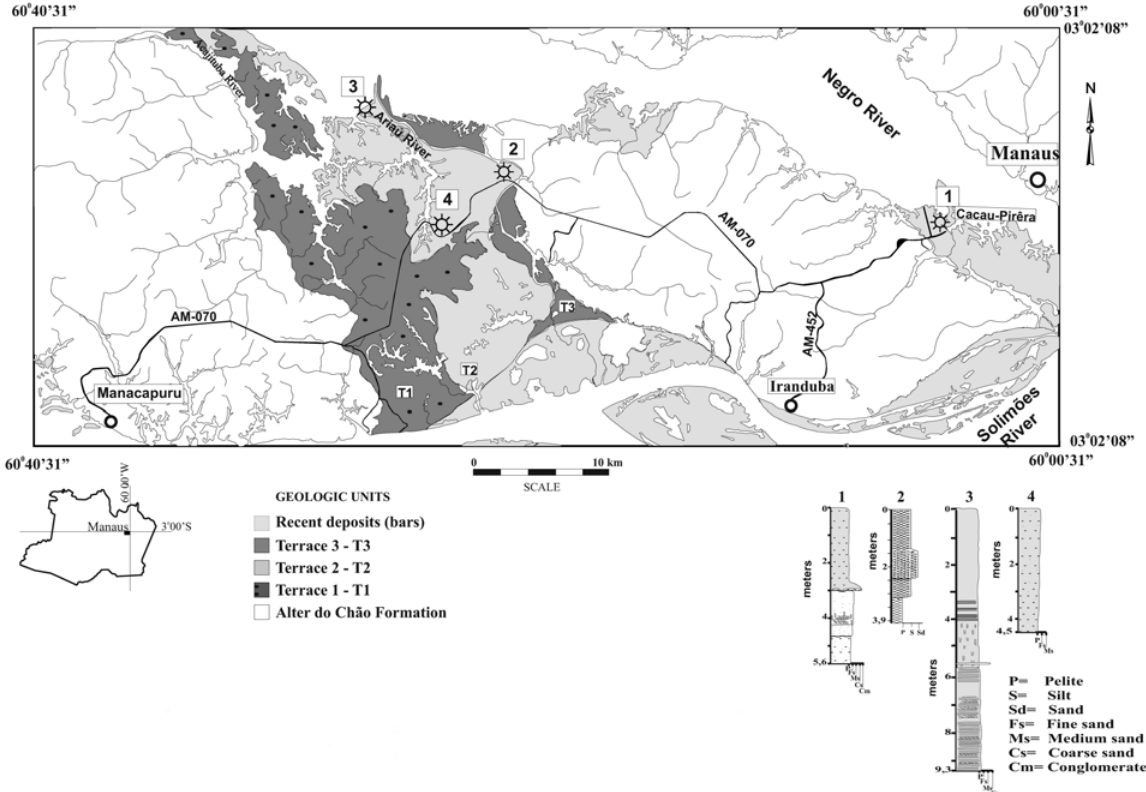
Fig. 5 – Geological map with the location of the Iranduba and Ariaú region with stratigraphic sections. Points 1, 2, 3 and 4 correspond to the respective sedimentological profiles. Modified from Soares et al.